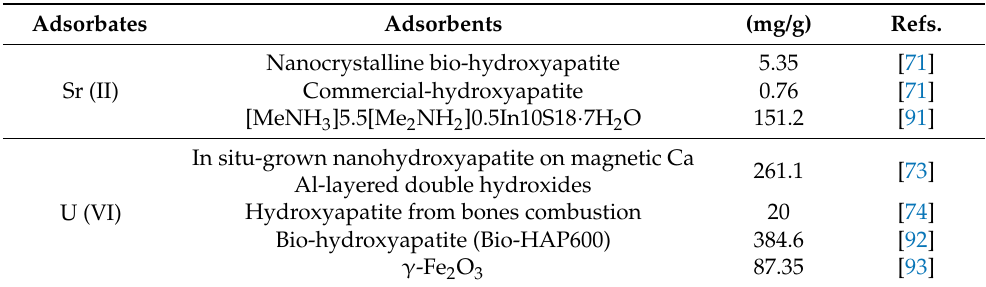
Table 2. Comparison of the adsorption capacities of nano HAp and its composites with other absorbents on